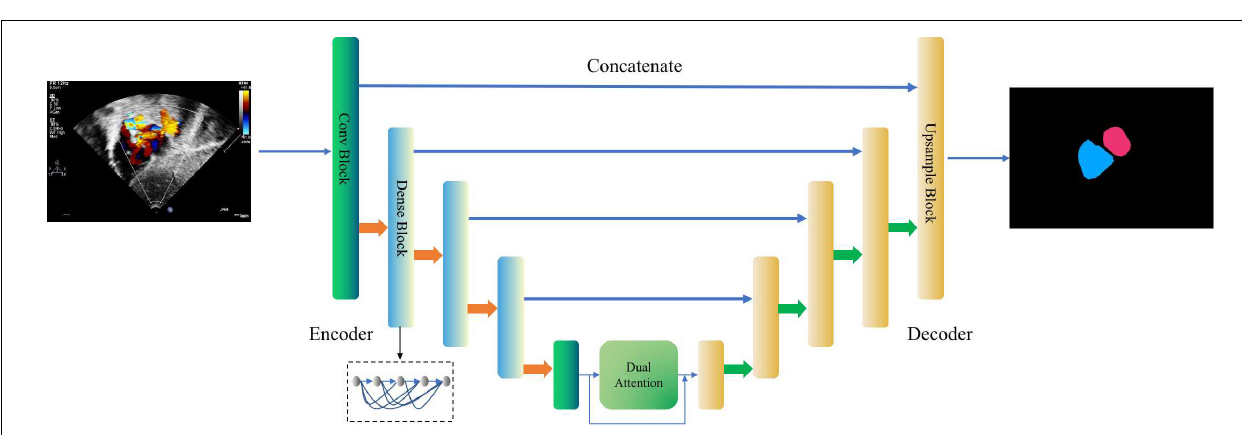
FIGURE 3 | Dense Dual Attention U-Net based segmentor for cardiac anatomy segmentation. The second, third, and fourth layers of the encoder apply the dense blocks, containing 2, 4, and 8 dense layers, respectively, with a growth rate of 32. The dual attention module includes a position attention module and a channel attention module, respectively. The two modules process the input in parallel, and the two outputs are fused by